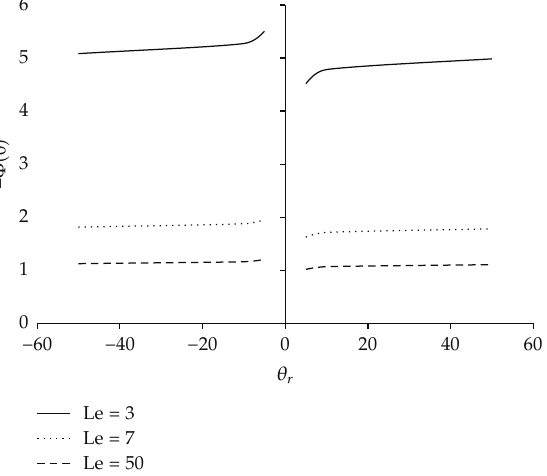
Figure 11: E ff ect of Lewis number Le on the rate of mass transfer for di ff erent values of θ r for Du (cid:8) 0 . 03, Sr (cid:8) 2, N (cid:8) 1, Pr (cid:8) 0 . 71, and Sc (cid:8) 0 .